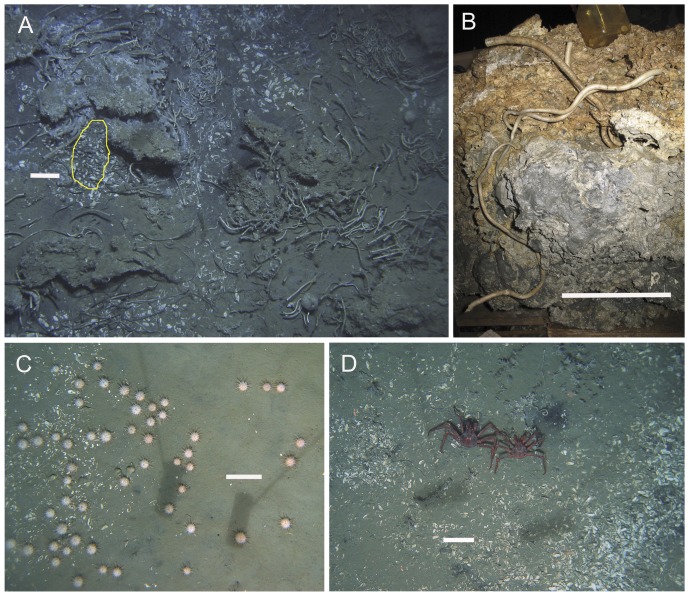
Hikurangi Margin cold seep habitats and fauna (2).(A) ‘Chemoherm’ habitat at Southwest Moa showing Lamellibrachia sp. tubeworms in association with authigenic carbonates, live Calyptogena sp. clams (yellow outline) and disarticulated shell valves, two spherical Stelletta n. sp. sponges, grey bacterial mats on carbonates (at upper left), and sulphidic sediments; (B) Underside of a carbonate block recovered by grab from chemoherm at North Tower, showing Lamellibrachia sp. tubes rooted in soft, grey, sulphide-rich, anoxic material at the base of the block; (C) Gracilechinus multidentatus sea urchins with Calyptogena sp. shell debris on soft sediments at the periphery of Tui seep; (D) Lithodes aotearoa crabs amongst Calyptogena sp. shell debris at Tui seep. Scale bars show 0.2 m.